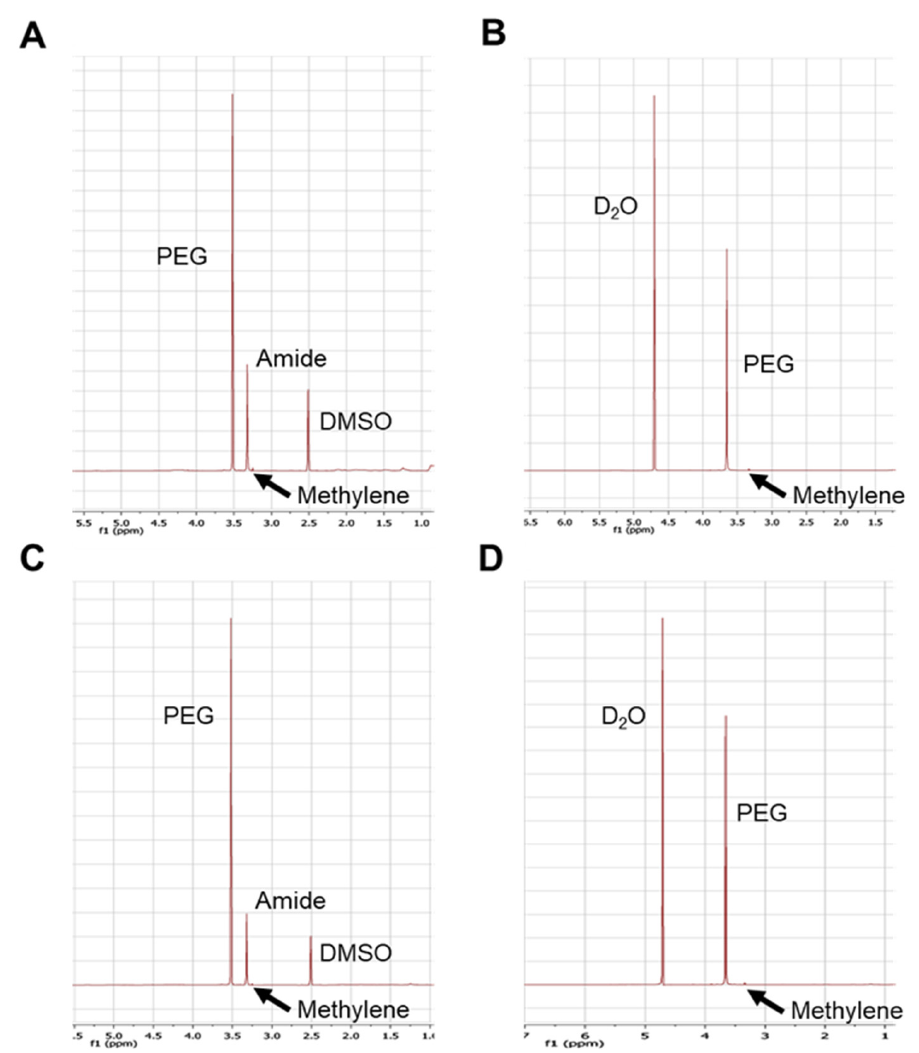
Figure 1. 1 H NMR spectra of mPEG5K ‐ zein in DMSO ‐ d 6 ( A ) and in D 2 O ( B ), mPEG10K ‐ zein in DMSO ‐ d 6 ( C ) and in D 2 O ( D ).